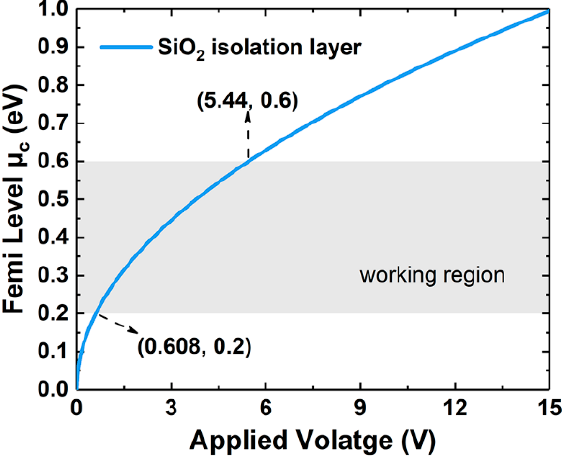
Figure 4. Fermi level μ c of graphene versus the change of applied external voltage.